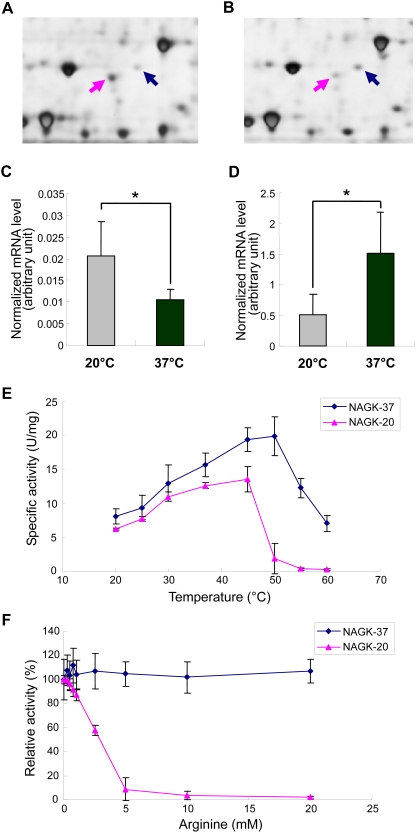
Proteomics, transcriptional and biochemical analysis of N-acetyl-L-glutamate kinase (NAGK)-20 and NAGK-37.Differential expressions of NAGK-20 (pink arrow) and NAGK-37 (blue arrow) in L. hongkongensis cultured at 20°C (A) and 37°C (B). Normalized mRNA levels of argB-20 (C) and argB-37 (D) in L. hongkongensis cells cultured at 20°C and 37°C. Data were analyzed by unpaired Student's t-test. The data represent the means of three independent experiments. Error bars represent standard deviations. Significant changes are represented by asterisks (*, P<0.05). (E) Specific kinase activities of purified NAGK-20 (pink) and NAGK-37 (blue) measured at different temperatures (25–60°C). The data represent the means of three independent experiments. Error bars represent standard deviations. (F) Effects of arginine on kinase activities of purified NAGK-20 (pink) and NAGK-37 (blue) measured in arginine at different concentrations (0.25–20 mM). The data represent the means of three independent experiments. Error bars represent standard deviations.